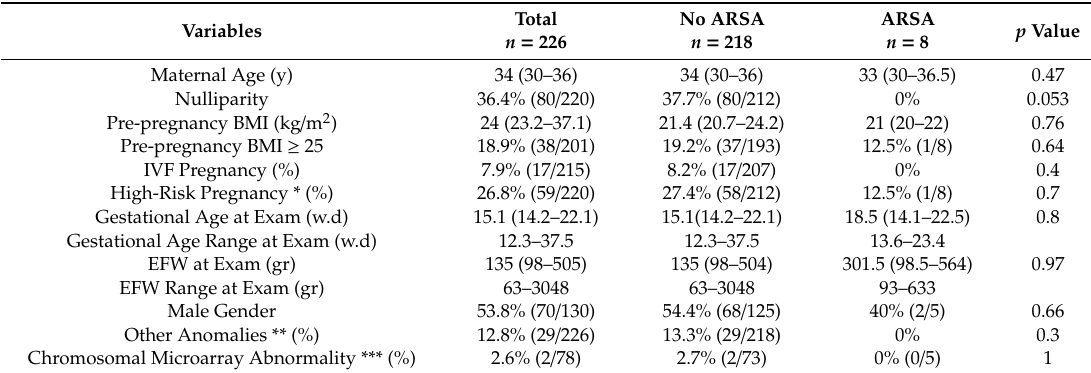
Table 1. Characteristics of study